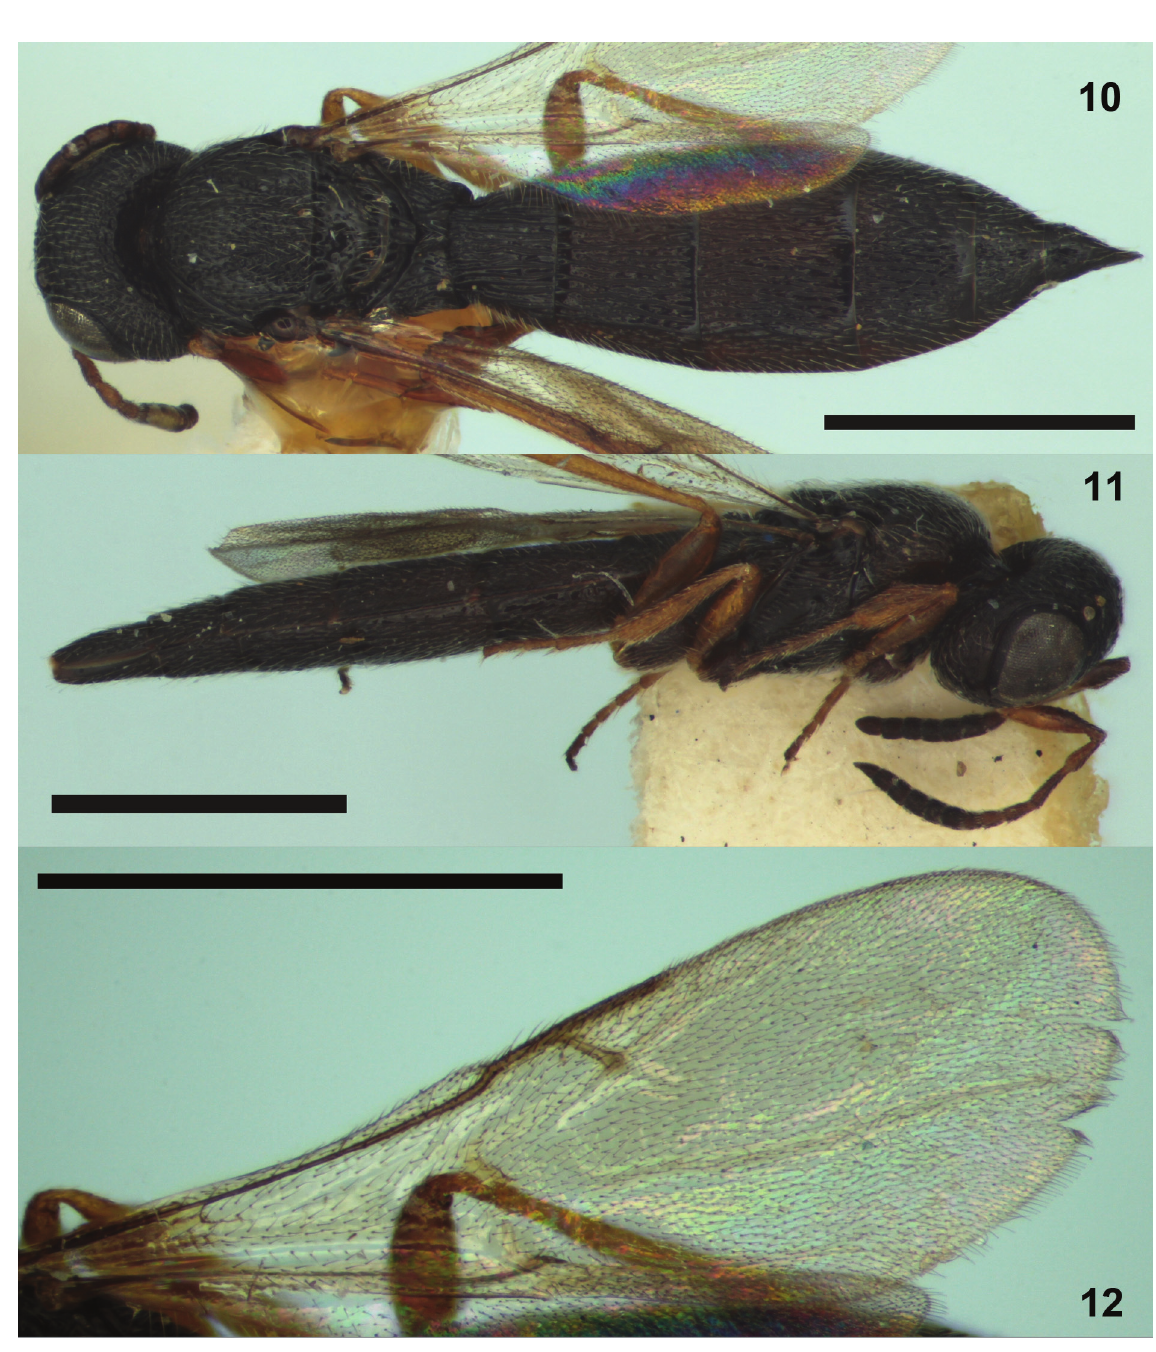
Figs 10–12. Macroteleia brevigaster Masner, 1976, ♀. 10 . Dorsal habitus. 11 . Lateral view. 12 . Fore wing. Specimen numbers bMNh(e)968239 and bMNh(e)968240. Scale bars all 1 mm. © Natural history Museum,